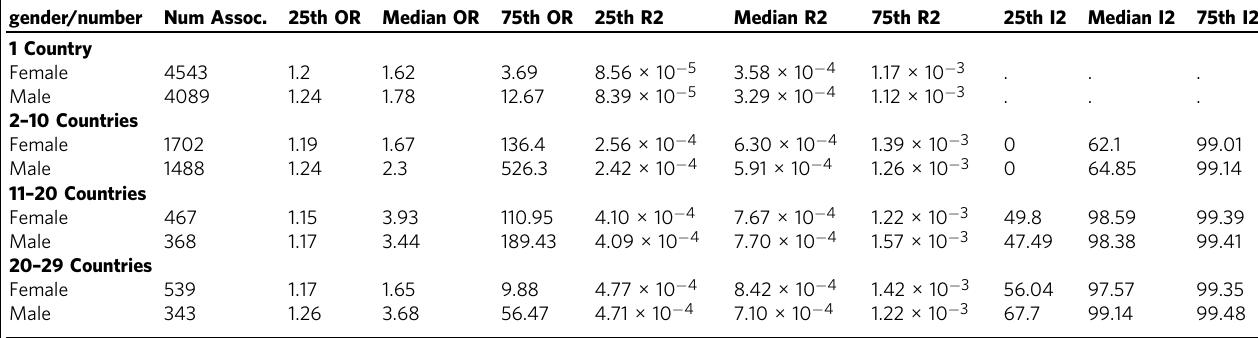
Table 2 Distributions of odds ratios, Nagelkerke R 2 , and I 2 (heterogeneity) estimates across countries. gender/number Num Assoc. 25th OR Median OR 75th OR 25th R2 Median